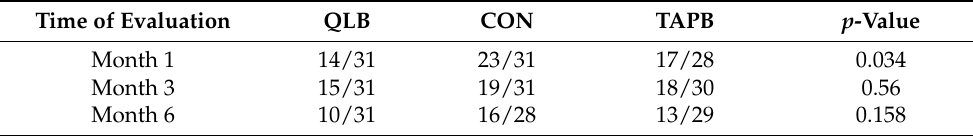
Table 5. Number of patients with persistent